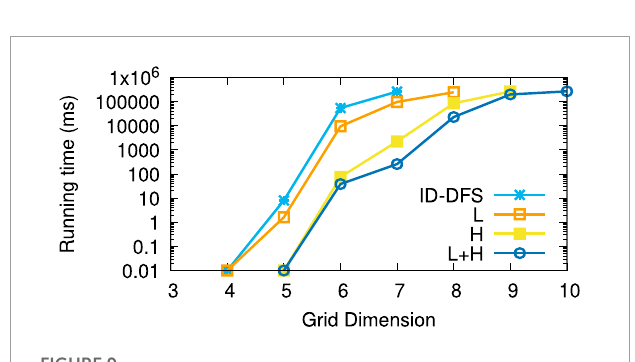
FIGURE 9 Average running times (in ms) for the type (d) (simple shapes) grids.